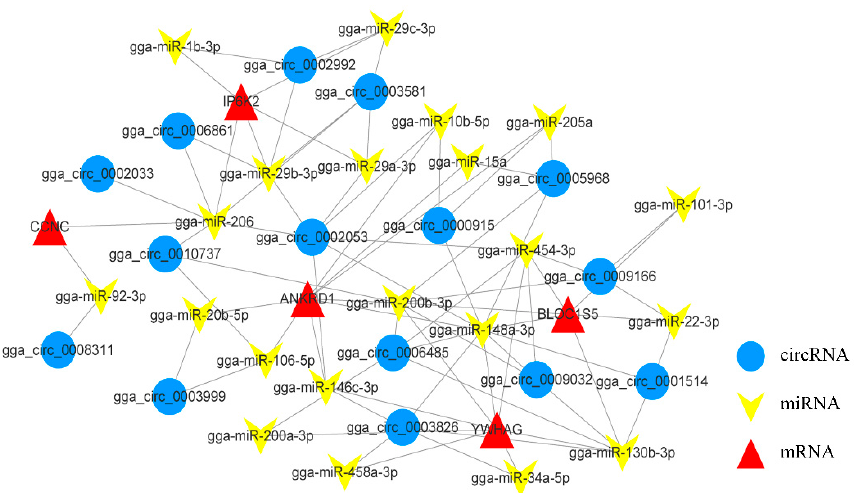
Figure 7. CircRNA-miRNA-gene interaction network related to cell growth. The circle, inverted arrows, and triangles represent circRNAs, miRNAs, and mRNAs, Figure 7. CircRNA ‐ miRNA ‐ gene interaction network related to cell growth. The circle, inverted ar ‐ rows, and triangles represent circRNAs, miRNAs, and mRNAs, respectively.